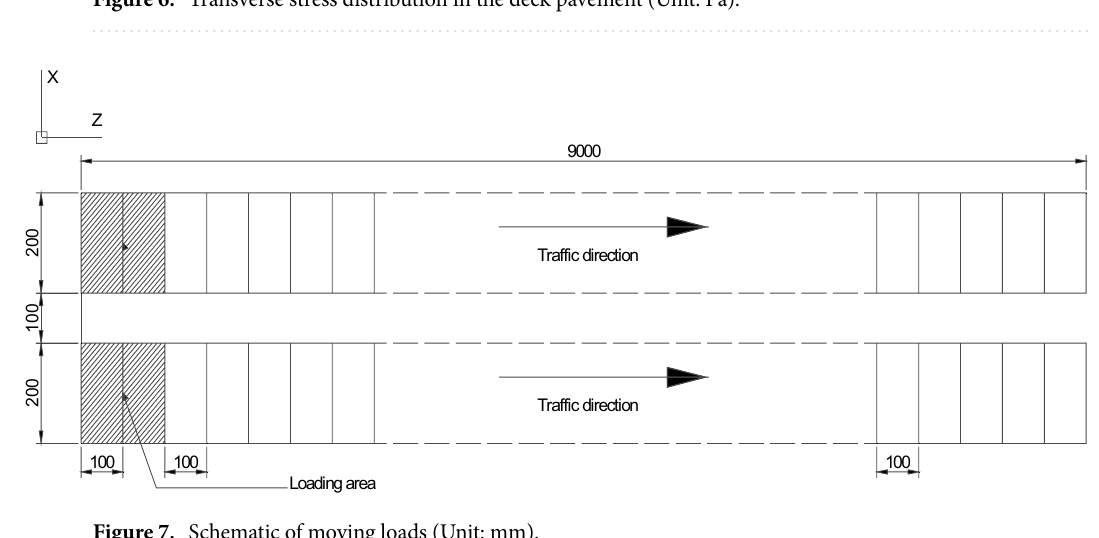
Figure 7. Schematic of moving loads (Unit: